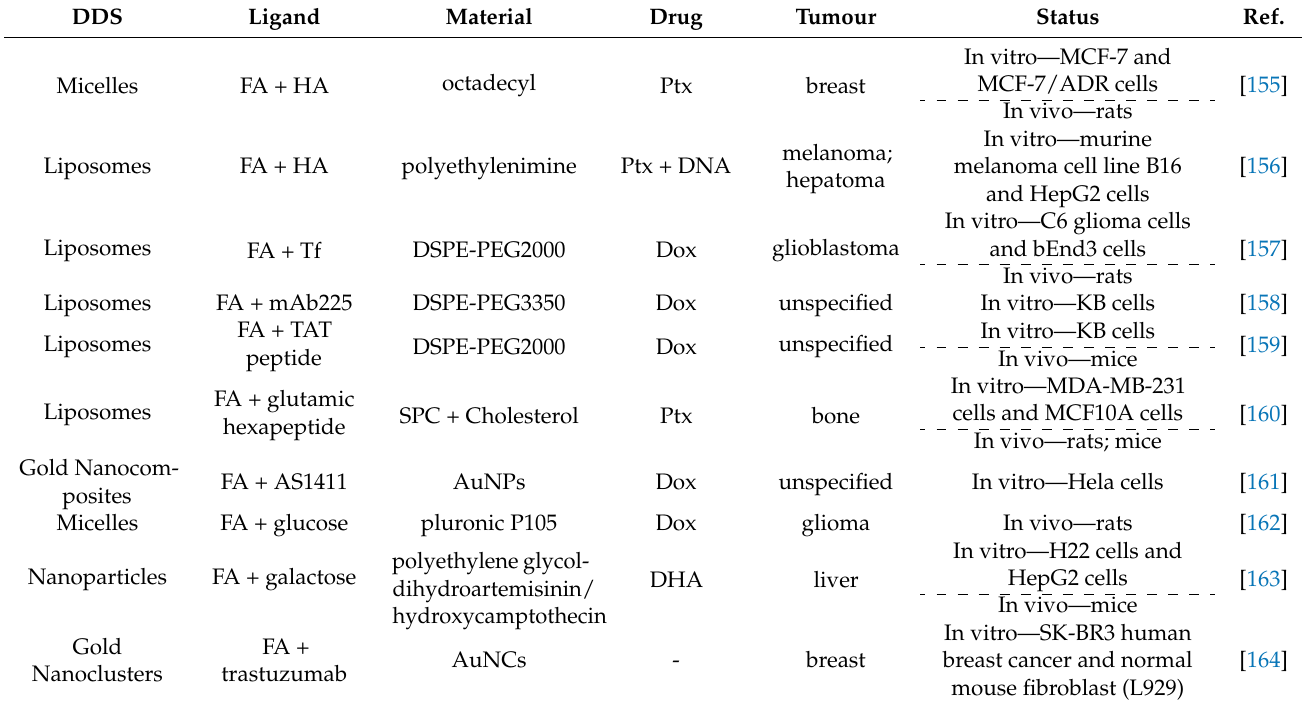
Table 5. The examples of dual-targeted nanoparticles with folic